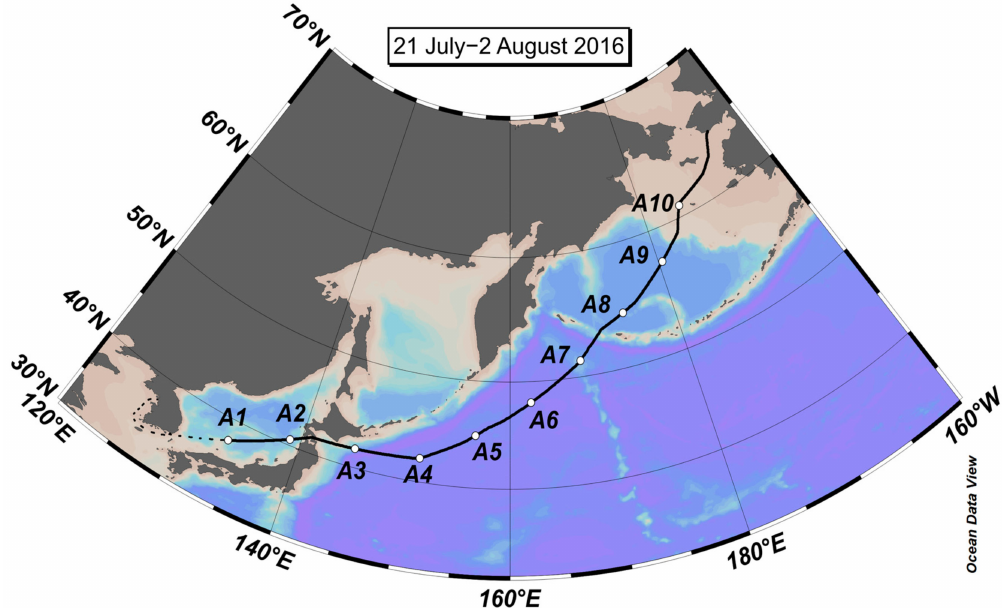
Figure 1. Cruise track of the ARA07A cruise during 21 July − 2 August 2016. White circles indicate aerosol sampling locations. Each aerosol sampling start point represents the end of the previous sampling period. The dotted line indicates that no aerosol sampling was